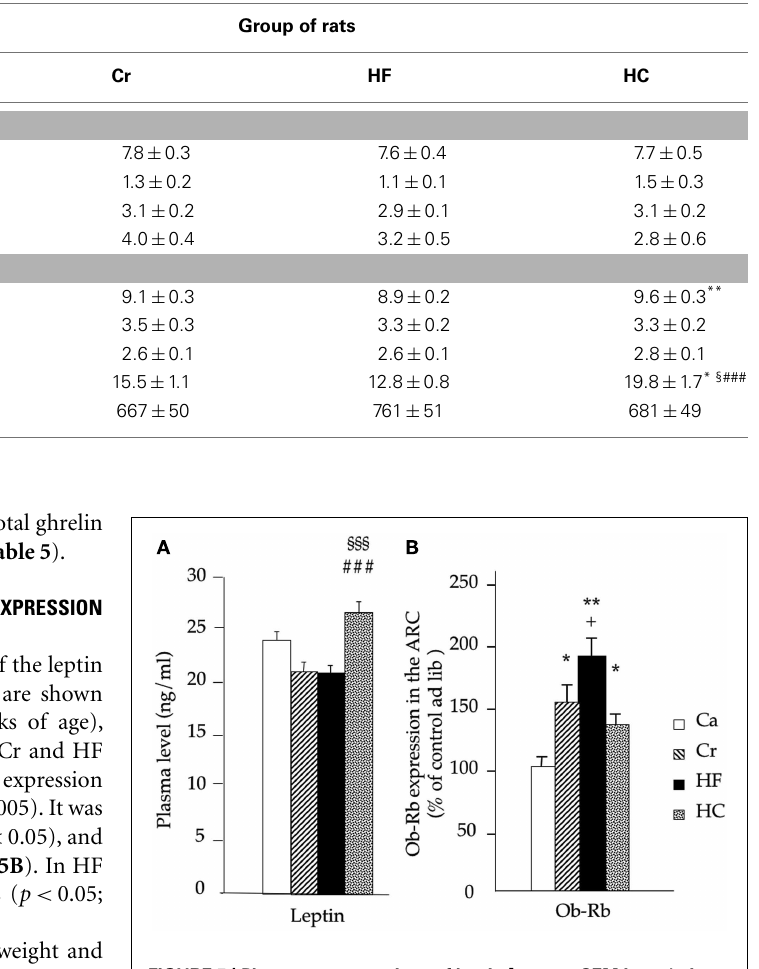
FIGURE 5 | Plasma concentrations of leptin [mean ± SEM in ng/mL; (A)] and mRNA expression of the long form of leptin receptor (Ob-Rb) in the arcuate (ARC) nucleus of the hypothalamus (B) in adult offspring from dams fed during gestation either a control diet (Ca group) ad libitum , or a restricted control (Cr group), a high-fat (HF group) or a high-carbohydrate (HC group) diet ad libitum for 6h during the light period, in addition to two normal meals given during the dark period. * p < 0.05, and ** p < 0.01 vs Ca; ### p < 0.001 vs HF; + p < 0.05 vs HC; § p < 0.05 and §§§ p < 0.001 vs